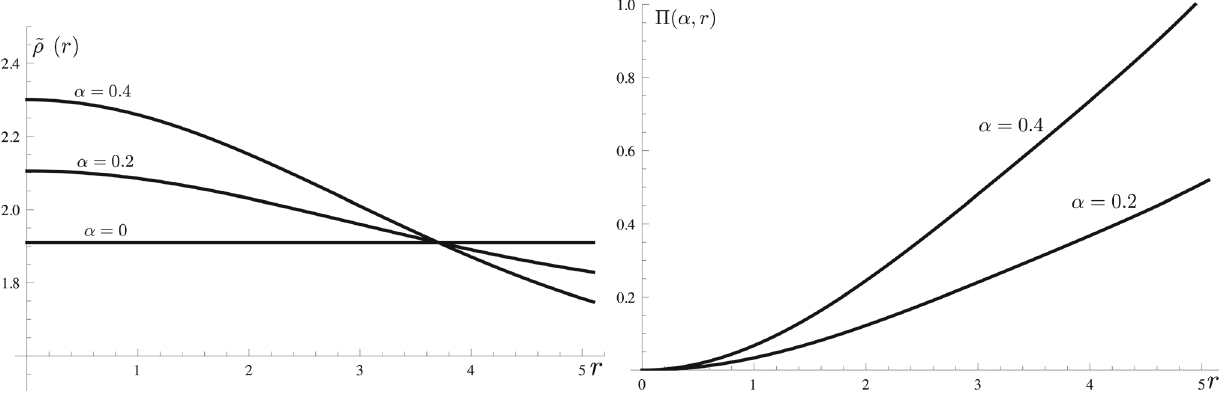
Fig. 1 Effective radial pressure ˜ p r ( r ) [10 − 4 ] and effective tangential pressure ˜ p t ( r ) [10 − 4 ]forastellarsystemwithcompactness M / R = 0 . 2 compared to the standard Schwarzschild case α = 0 with p r = p t .